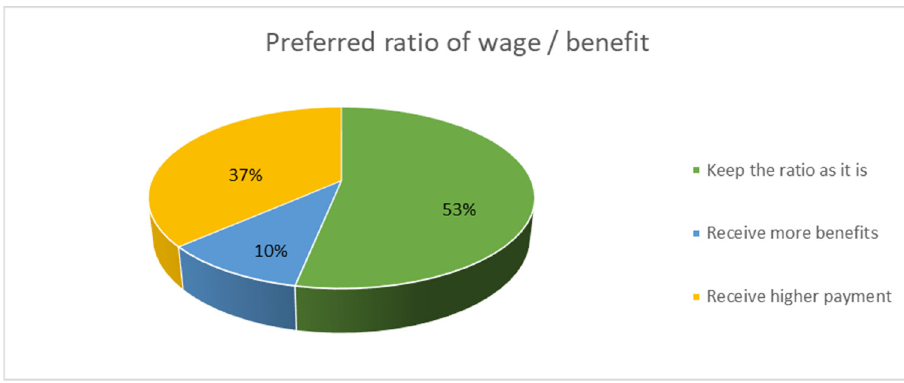
Figure 4. Percentage of employees who prefer to keep the ratio wage/benefit as it is compared to changing it.